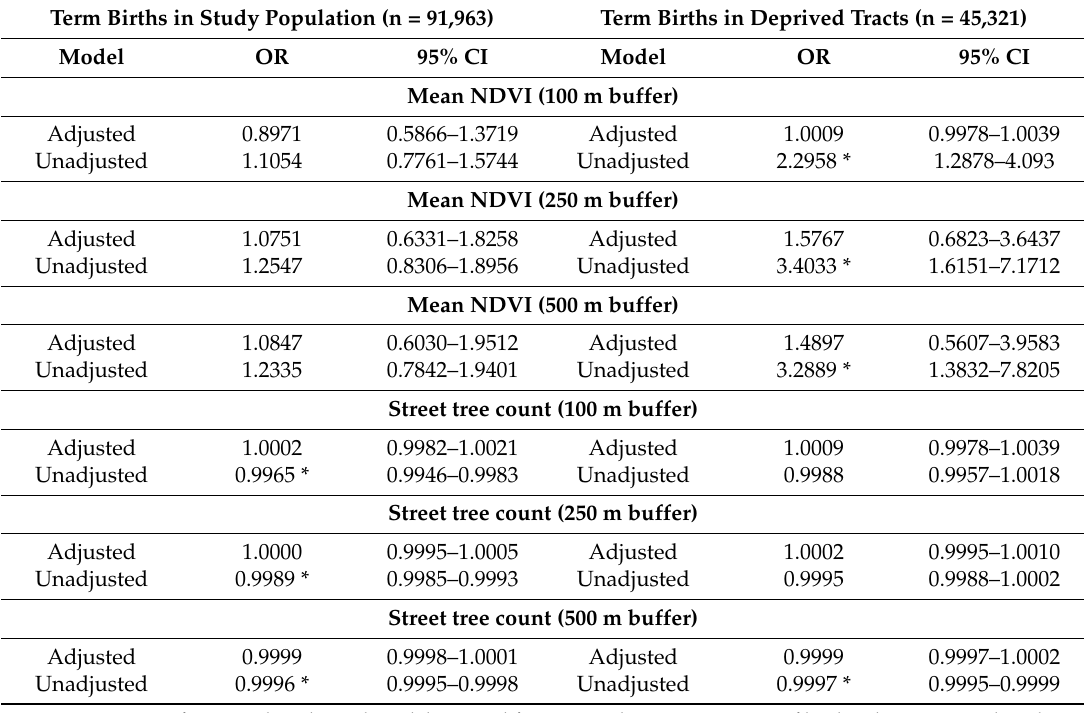
Table 5. Mixed-effects logistic regression results for the odds of term low